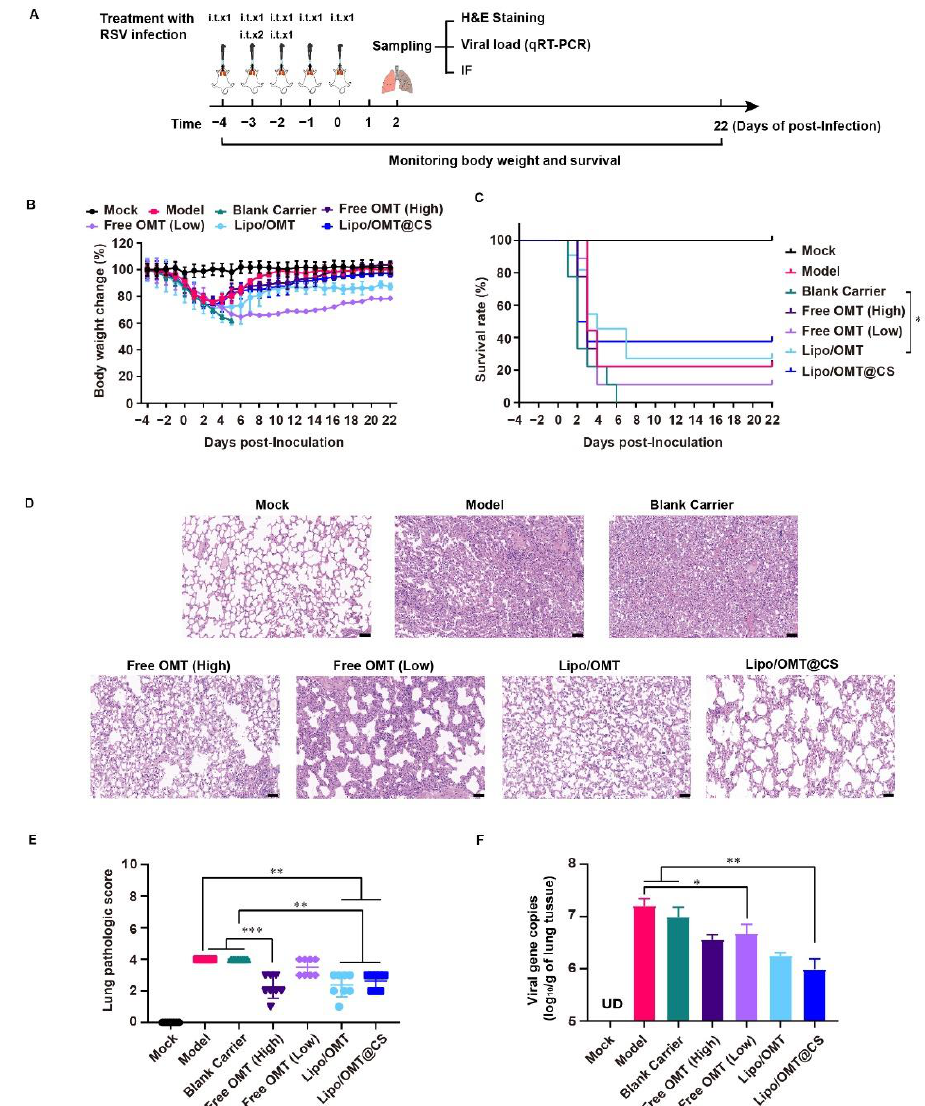
Figure 6. Alleviative effect of OMT liposomal preparations on RSV-infected mice. ( A ) Schematic illustration for the evaluation of alleviative effect of OMT liposomal preparations on RSV-infected mice. ( B , C ) Body weight change and survival rate of Mock ( n = 8 at beginning), Model ( n = 9 at beginning), Blank Carrier ( n = 9 at beginning), Free OMT (High) ( n = 9 at beginning), Free OMT (Low) ( n = 9 at beginning), Lipo/OMT ( n = 11 at beginning), and Lipo/OMT@CS ( n = 8 at beginning). The timepoint of 22 DPI was set as end point of recording. Data for body weight change are expressed as mean ± SD. ( D ) H&E staining of pathologic sections of lung tissues for each group at 2 DPI (scale bar = 50 µ m). ( E ) The lung pathologic scores basic on the H&E staining were double-blinded and accessed by anonymous pathologists and statistically processed. Data are expressed as mean ± SD ( n = 8). ( F ) The qRT-PCR results for viral gene copies of lung BALF samples. Data are expressed as mean + SD ( n = 3). UD: under detectable. * p < 0.05, ** p < 0.01, *** p < 0.001.